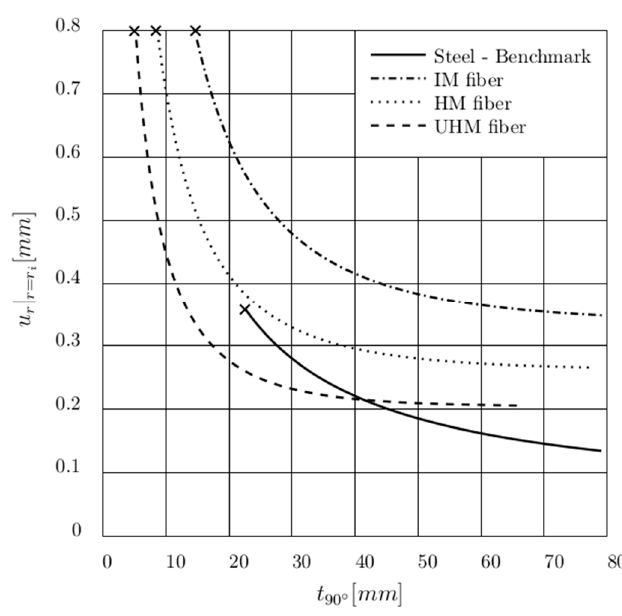
Figure 4. Radial displacement at inner radius vs. wall thickness at first-yield pressure.